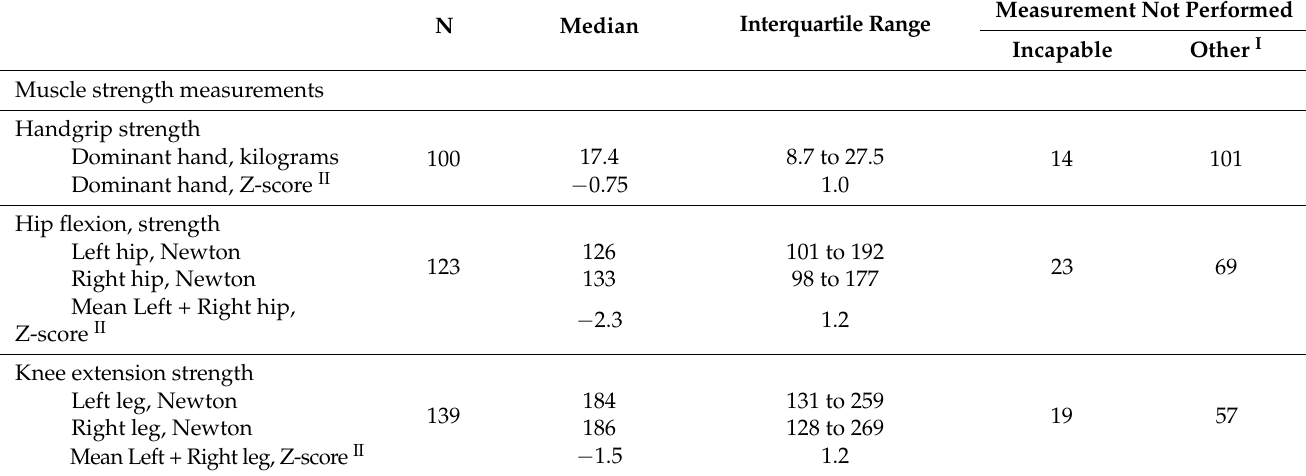
Table 2. Results of physiotherapy assessments (n =